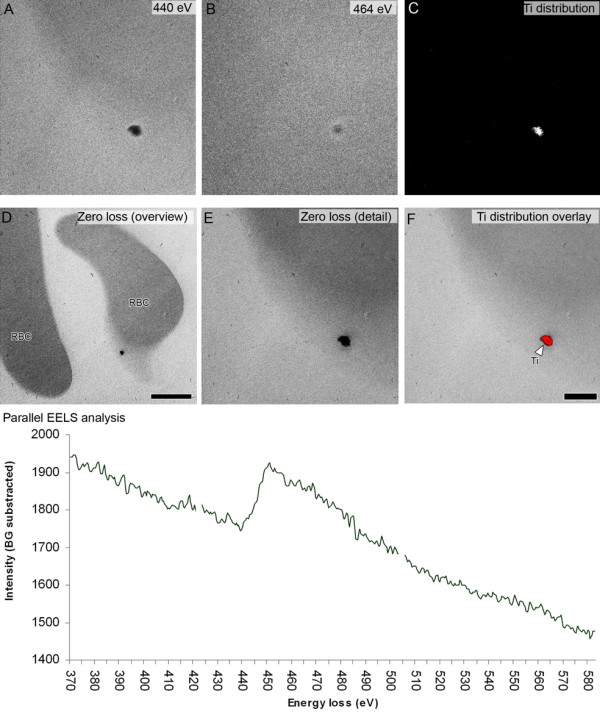
Titanium detection by ESI and pEELS. A and B show an energy loss imaging (ESI) series of the L3 orbital of Ti at 440 eV (background) and 464 eV (signal) in an erythrocyte culture. In C, the resulting difference is calculated, revealing the distribution of Ti in the sample. Not shown, but used in the three-window calculation of the Ti distribution is a second background window recorded at 390 eV. The occurrence of Ti is confirmed by parallel electron energy loss spectroscopy (pEELS), shown in the graph. The energy a beam electron looses when interacting with the sample is representative for the atom and orbital it is interacting with. The graph shows a peak intensity around 460 eV, indicative for the interaction with the L3 orbital of Ti (the background follows a negative exponential progression). The zeroloss overview and detail images show a dark particle near a red blood cell. With pEELS confirming the occurrence and ESI revealing the distribution, the particle can be appointed as containing Ti. Bars = 1 μm (D), 250 nm (A to F except D). Titanium dioxide particles were incubated with erythrocytes and fixed and embedded conventionally. The section was placed on a Ni-grid. No supportive film and no staining were used. Zeroloss measuring of the relative thickness of the section at 10 different positions revealed a t/λ of 0.38 (+/- 0.04).